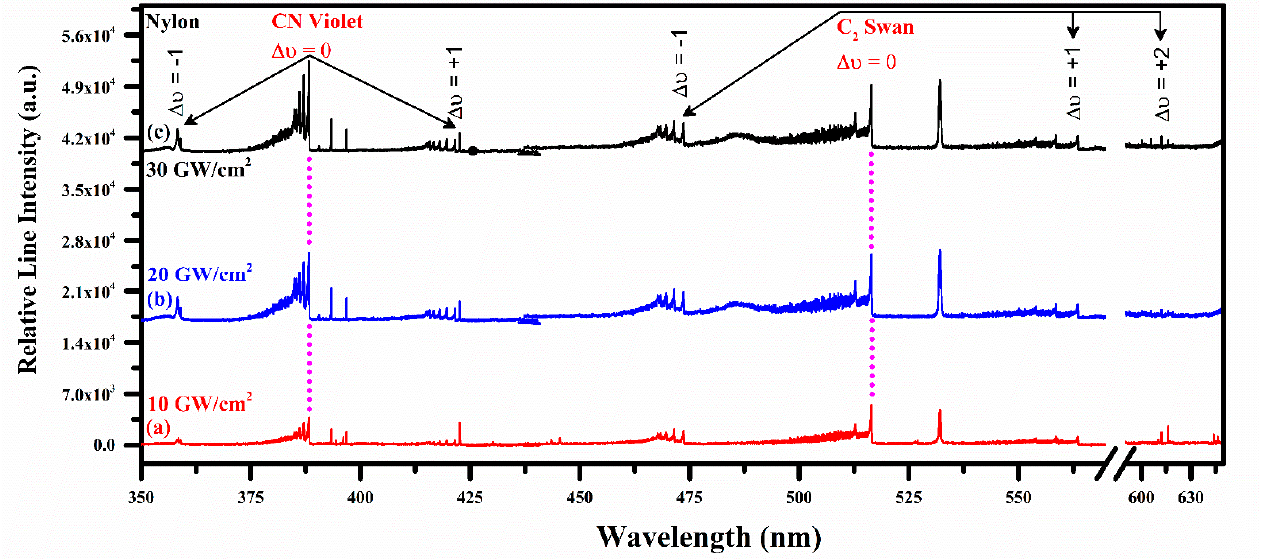
Figure 3 . Time-integrated spectrum of the pure organic nylon from 350 nm to 645 nm at different laser irradiance (GW/cm 2 ) showing CN and C 2 vibrational optical emissions.